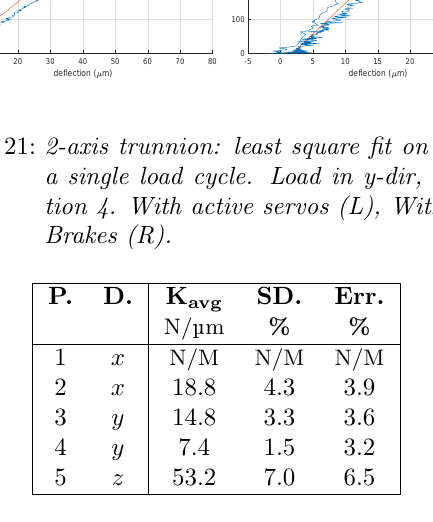
Table 8: 2-Axis trunnion: average stiffness and stan- dard deviation from test measurements at dif- ferent positions and directions. Active servos.